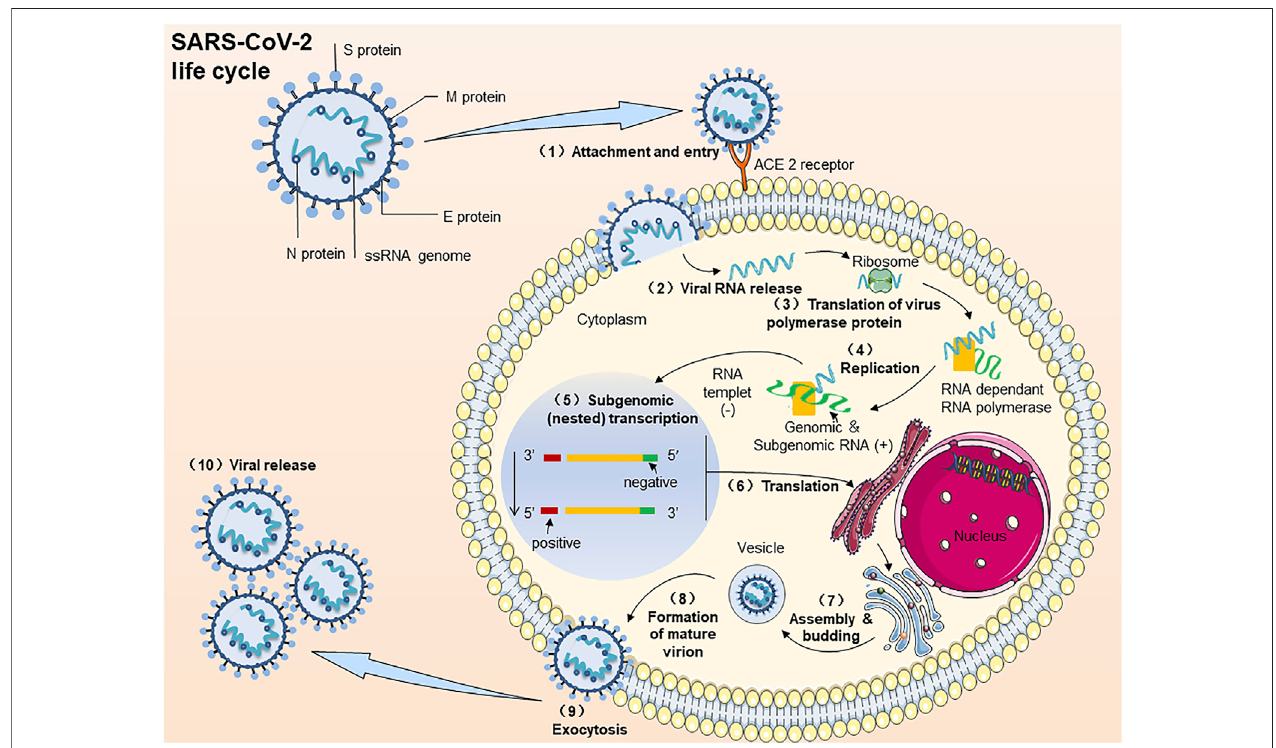
FIGURE2| TheprocessofSARS-CoV2virusinfectionofhostcells.Note:ThereplicationcycleofSARS-CoV2invirus-susceptiblehostcells:(1)ACE2bindstothe RBD of the spike protein (S) and then fuses with the host cell membrane. (2) Release the positive single-stranded RNA. (3, 4) Partially translate into SARS-CoV2 polymeraseprotein. (5)Transcribe. (6)Theresultingsubgenomic RNAtranslatedS,M,and Eproteins aretransportedtotheERmembraneofthehostcelland thenbind tothenucleocapsidprotein(N).(7)To-afterprocessingintheGolgiapparatus.(8)Maturevirusparticlesareformedandtransportedtothecellmembrane.(10)New SARS-CoV2 particles are excreted by exocytosis